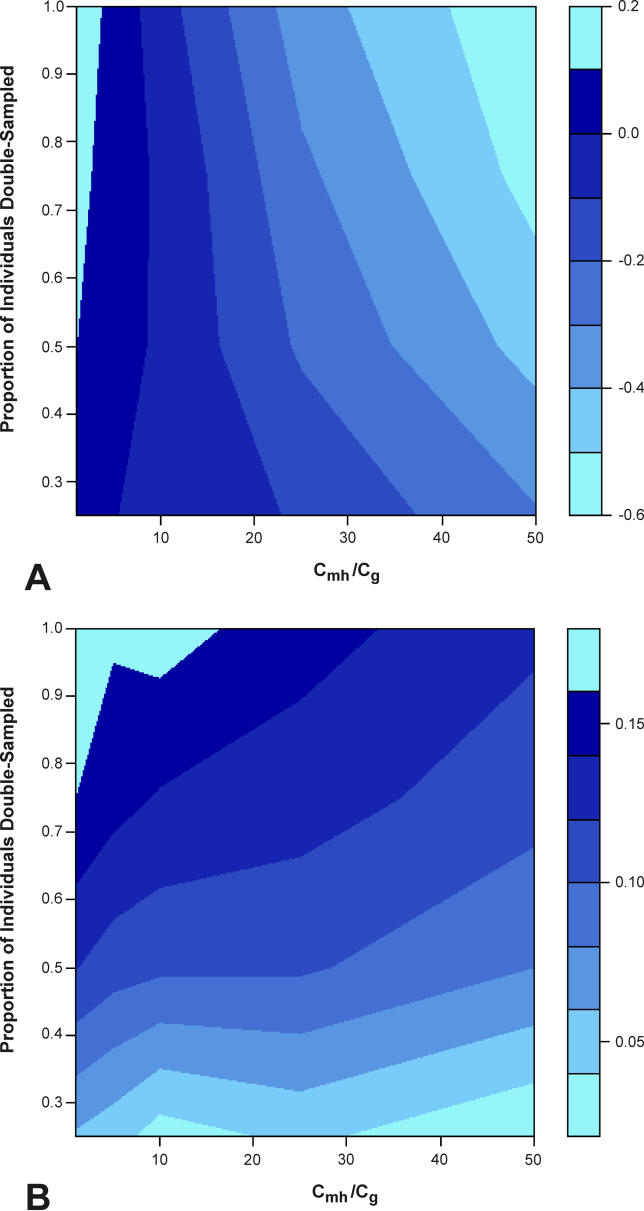
Contour Plots of the Power Difference between the LRTae and LRTstd Methods at Various SettingsVarious settings for the cost ratio of molecular haplotyping to genotyping (r) and the proportion of individuals double-sampled (α) are shown. Power is compared at the 0.001 significance level. The cost ratio of phenotyping to genotyping for (A) is 25 while the cost ratio of phenotyping to genotyping for (B) is 1,000. The generation of haplotype frequencies for the cases and controls was based on a dominant disease model with R2 = 3.5 and DAF = 0.07, as well as population haplotype frequencies of 0.05, 0.25, 0.15, and 0.55. The haplotype with frequency of 0.05 was placed in LD (D′ = 0.9) with the disease locus. LRTae was computed with the random double-sample selection method only. Haplotype pairs were inferred using SNPHAP v 1.3.1.